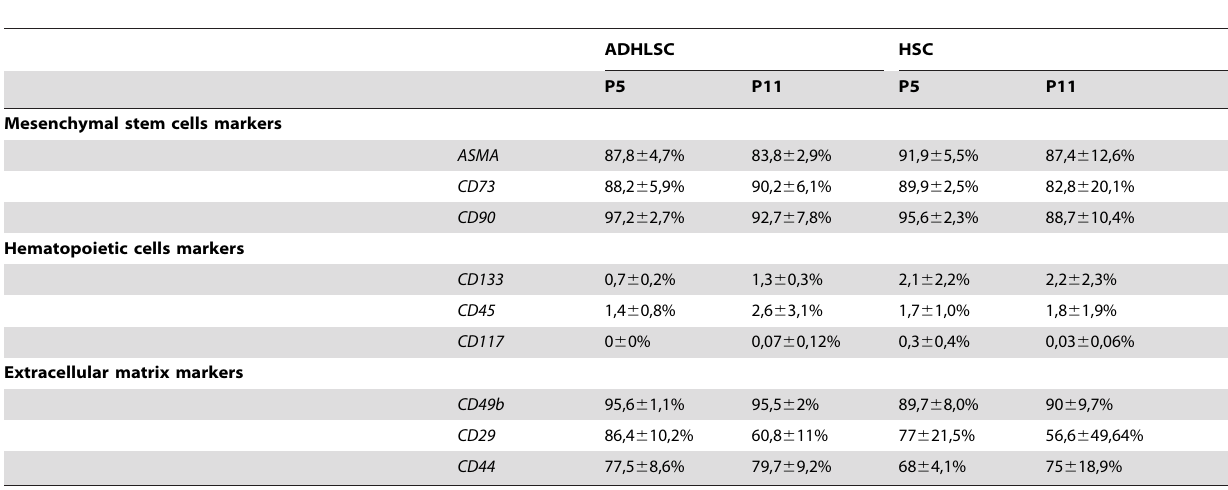
Table 4. Phenotypic characterization of ADHLSC and HSC by flow cytometry for mesenchymal stem cells, hematopoietic cells and extracellular matrix